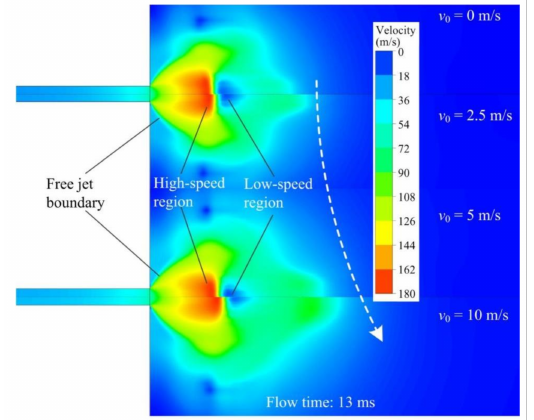
Figure 12. Effects of flow velocity on velocity distribution of near field